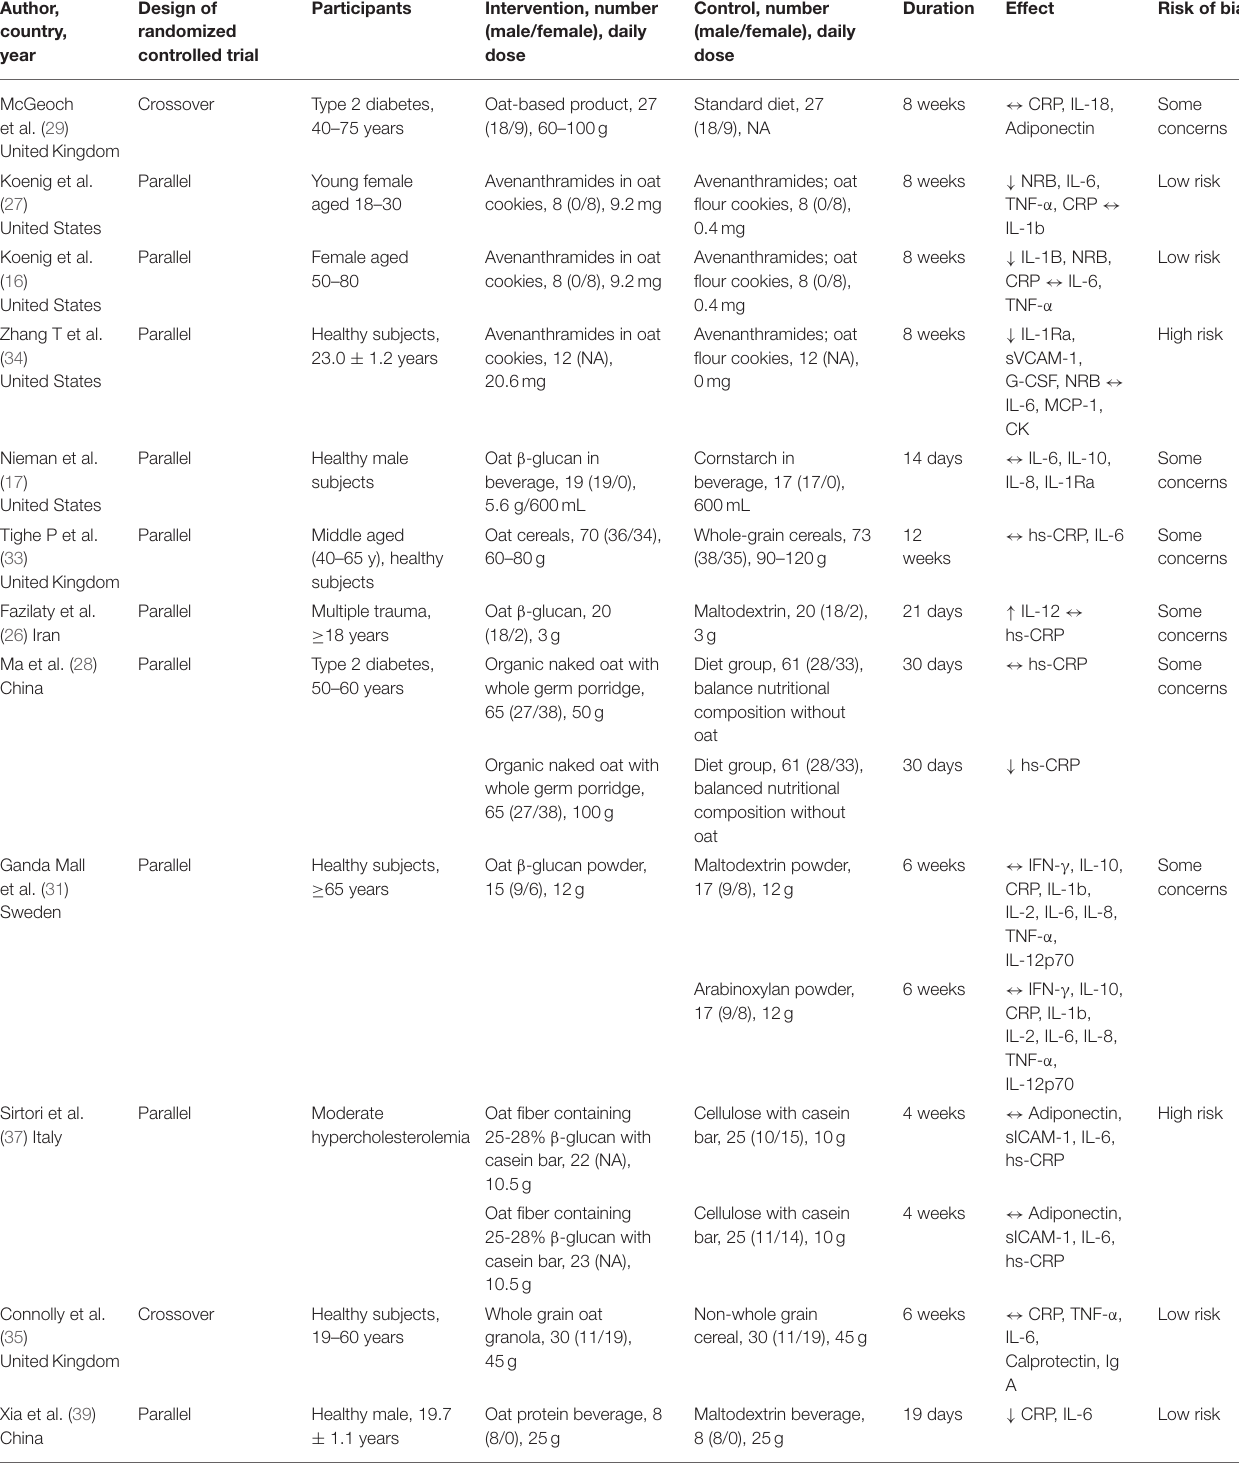
TABLE 3 | Study design, characteristics, and summary of